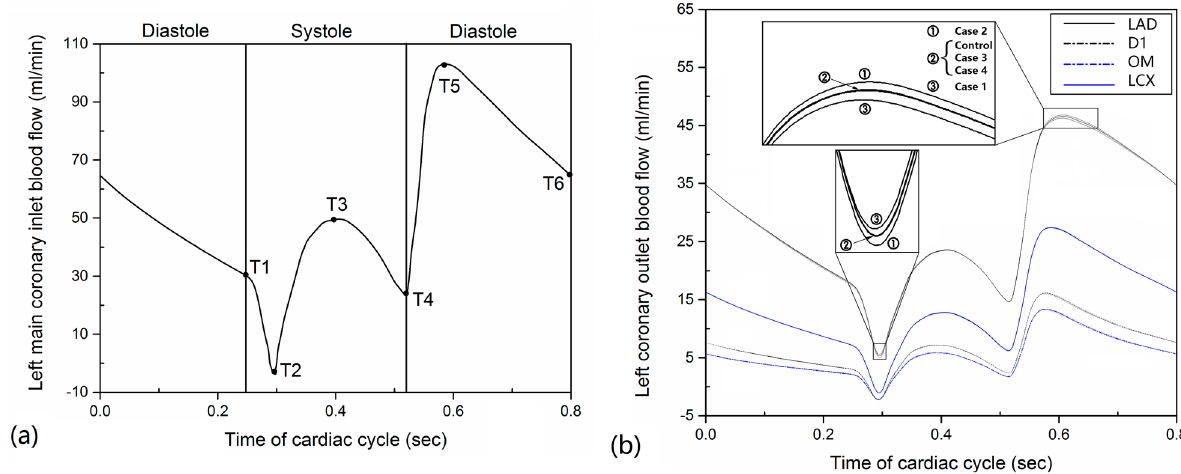
Figure 2. Pulsatile blood flow in human left coronary arteries. ( a ) A pulsatile inlet flow profile of the LMA . ( b ) Pulsatile outlet flow profiles of four coronary branch ends for the five simulation cases. Inserts are the pulsatile outlet flow profiles of the LAD . Case 1, Case 2, Case 3, and Case 4 respectively represent the condition of rigid wall, blood viscosity, blood pressure, wall thickness. Control represent the healthy